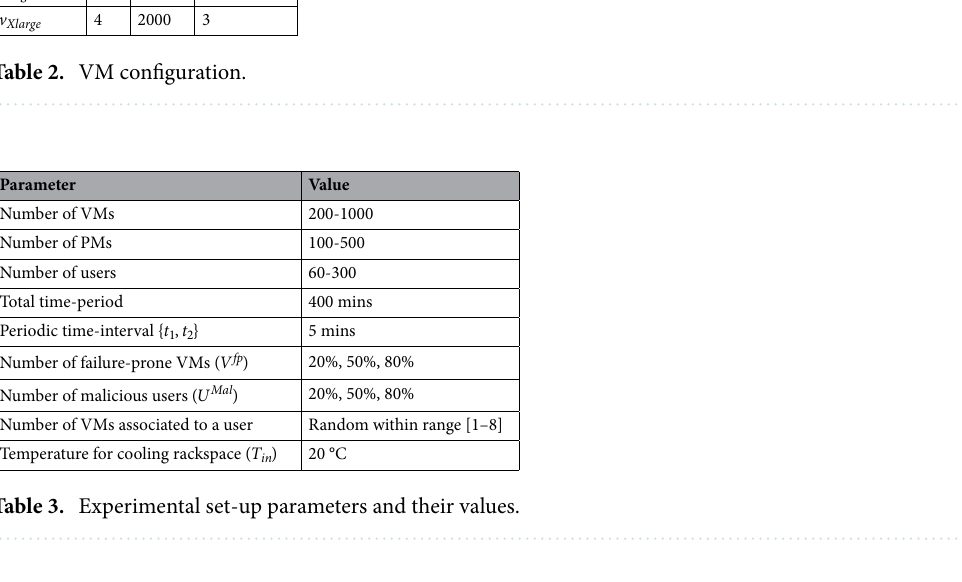
Table 4 reports the performance metrics: MAE ( ̟ MAE ), MSE ( ̟ MSE ), PUE, carbon footprint rate ( CFR ), resource contention rate ( RCR ), probability of co-residency threats ( (cid:31) ), power consumption ( PW ), resource utilization ( RU ), the number of VM migrations ( Mig # ), and SLA violation ( SLA V ) achieved for GCD workloads for varying sizes of the data centre (200–1000 VMs) over 400 minutes. The accuracy of forthcoming workload estimation using the proposed DPBHO optimized MFNN prediction unit governs the performance of the SaS-LM model. The average of failure prediction errors ̟ MAE and ̟ MSE